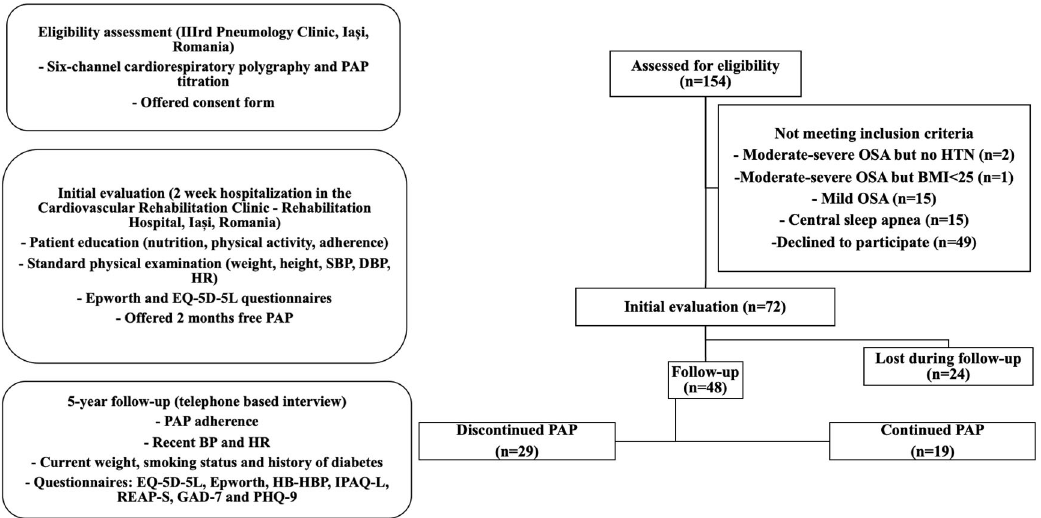
Figure 1. Flowchart diagram of patients referred to our sleep clinic January to December 2018. OSA: obstructive sleep apnea; HTN: hypertension; BMI: body mass index; PAP: positive airway pressure; SBP: systolic blood pressure; DBP: diastolic blood pressure; HR: heart rate; EQ-5D-5L: European Quality of Life 5 Domain questionnaire; HB-HBP: Hill-Bone HBP Compliance to High Blood Pressure Therapy Scale; IPAQ-L: International Physical Activity Questionnaire—Long Form; REAP-S: Rapid Eating Assessment for Participants—Shortened Version; GAD-7: General Anxiety Disorder Assessment; PHQ-9: Patient Health